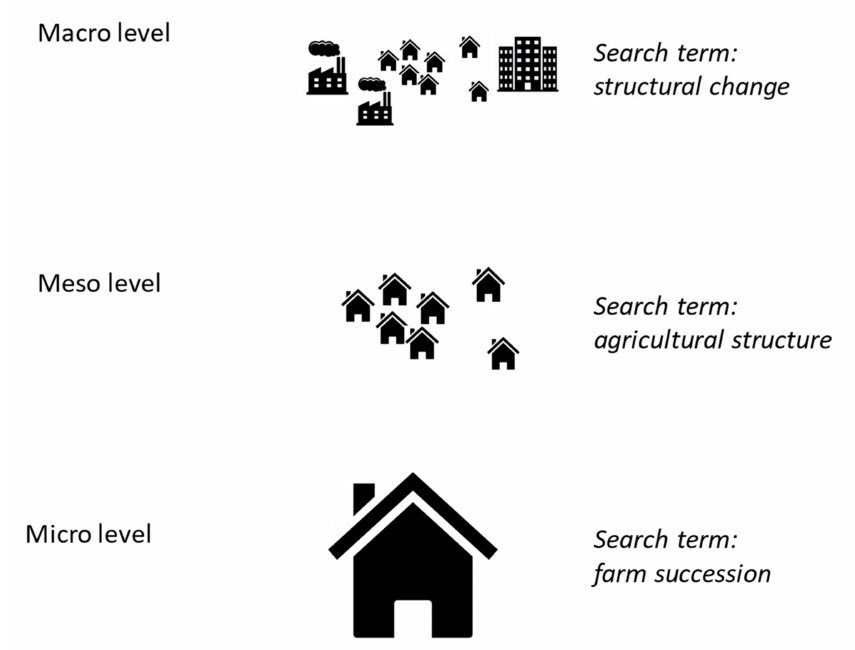
Figure 1. The search terms used in the study.